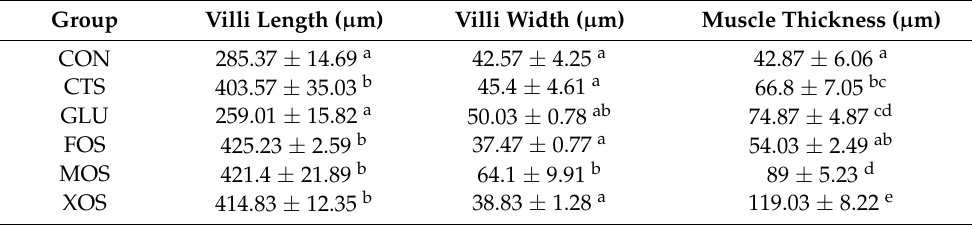
Table 2. Intestinal morphology of hybrid grouper fed with different prebiotics.